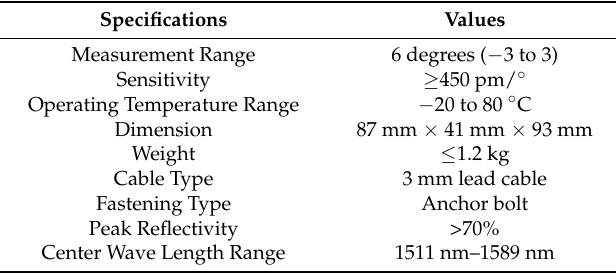
Table 3. Specifications of the FBG angle